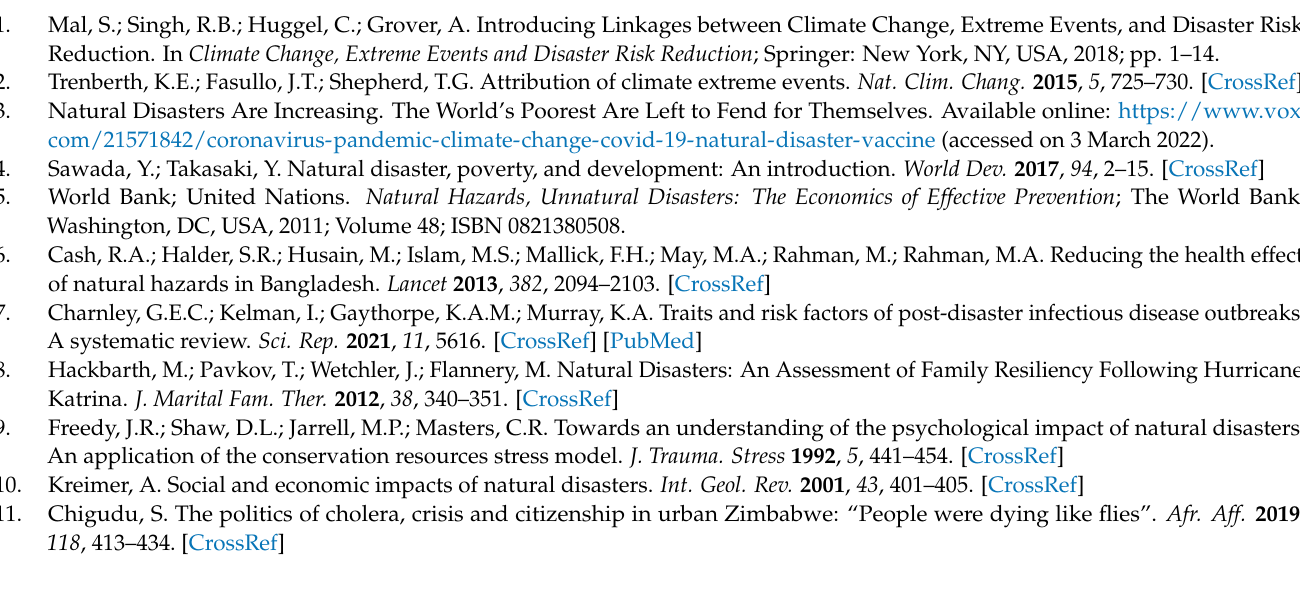
Table S4. Risk level classification for Model B